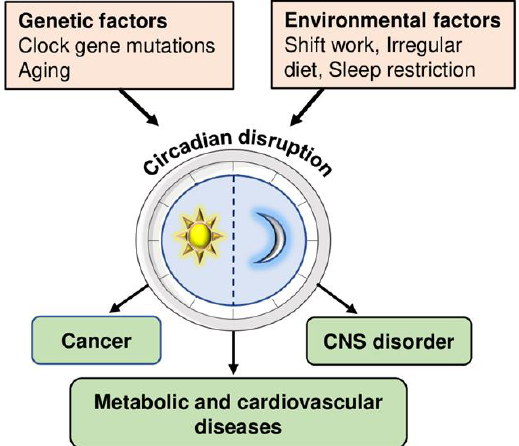
Figure 2. Genetic factors (age and mutations in clock genes) and environmental factors (sleep disturbances, irregular diet, and shift work) disrupt circadian rhythm. Disturbances in the oscillations of the circadian clock lead to cardiometabolic diseases, CNS disorders, and cancer. At the cellular level, circadian clock genes consist of transcription-translation feedback loops, in which Clock and brain and muscle Arnt-like protein-1 ( Bmal1 ) drive expres- sion of 2 negative-feedback arms controlled by Period/Cryptochrome ( Per / Cry ) and the two paralogs, Rev-Erb α and Rev-Erb β [32]. In turn, these negative-feedback arms repress Bmal1/Clock transactivation function (Per/Cry) or Bmal1 expression (Rev-Erb α / β ) and Bmal1 activation (ROR) (Figure 3).